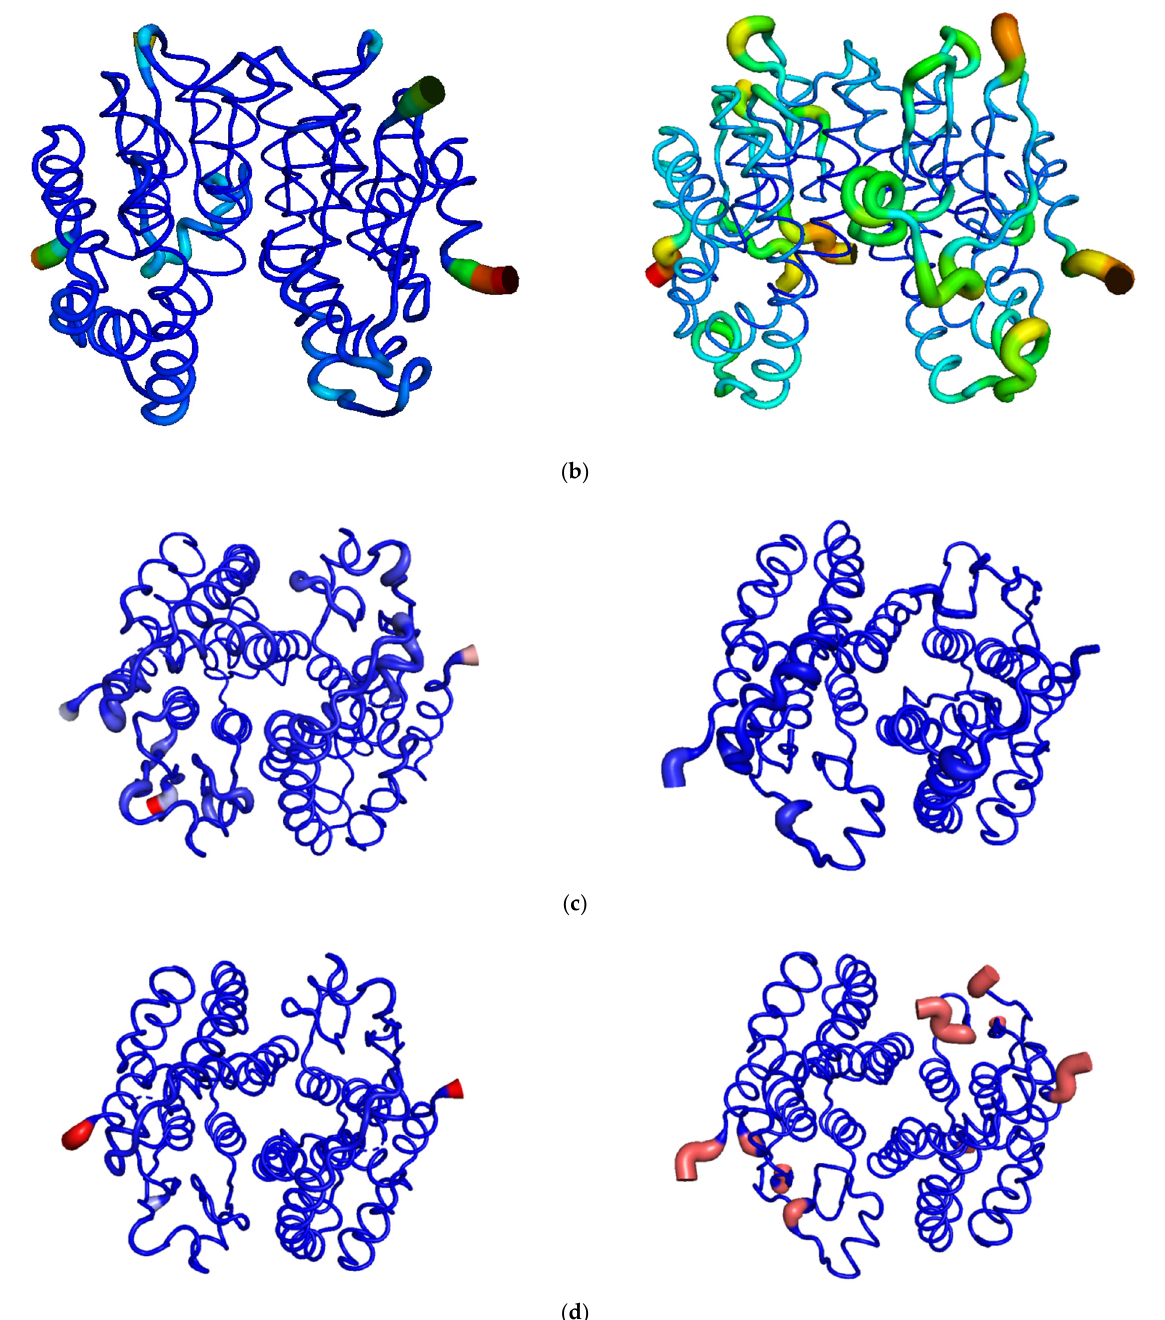
Figure 10. ( a ) Intersubunit structural communication between α 2 helix and the kinked large α 4 helix in the sh155 enzyme. The amino acid residue at position 90 and the lock-and-key forming residues (Phe52, Trp101 and Val104) are shown and labelled. Amino acid side chains are shown as sticks. ( b ) Structural flexibility along the polypeptide chain in the parent Am GSTF (left) and the sh155 enzyme variant (right). Regions of low mobility have a thinner backbone radius, whereas regions of higher mobility have a thicker backbone radius. The plots were produced by PyMol [61]. ( c ) Plot of defor- mation energy along the polypeptide chain of Am GSTF (left) and sh155 (right). ( d ) Plot of atomic fluctuation along the polypeptide chain of Am GSTF (left) and sh155 (right). The ( c , d ) plots were produced by DynaMut web server [62]. The deformation/fluctuation magnitude is represented by thin to thick tubes colored blue (low) to red (high).